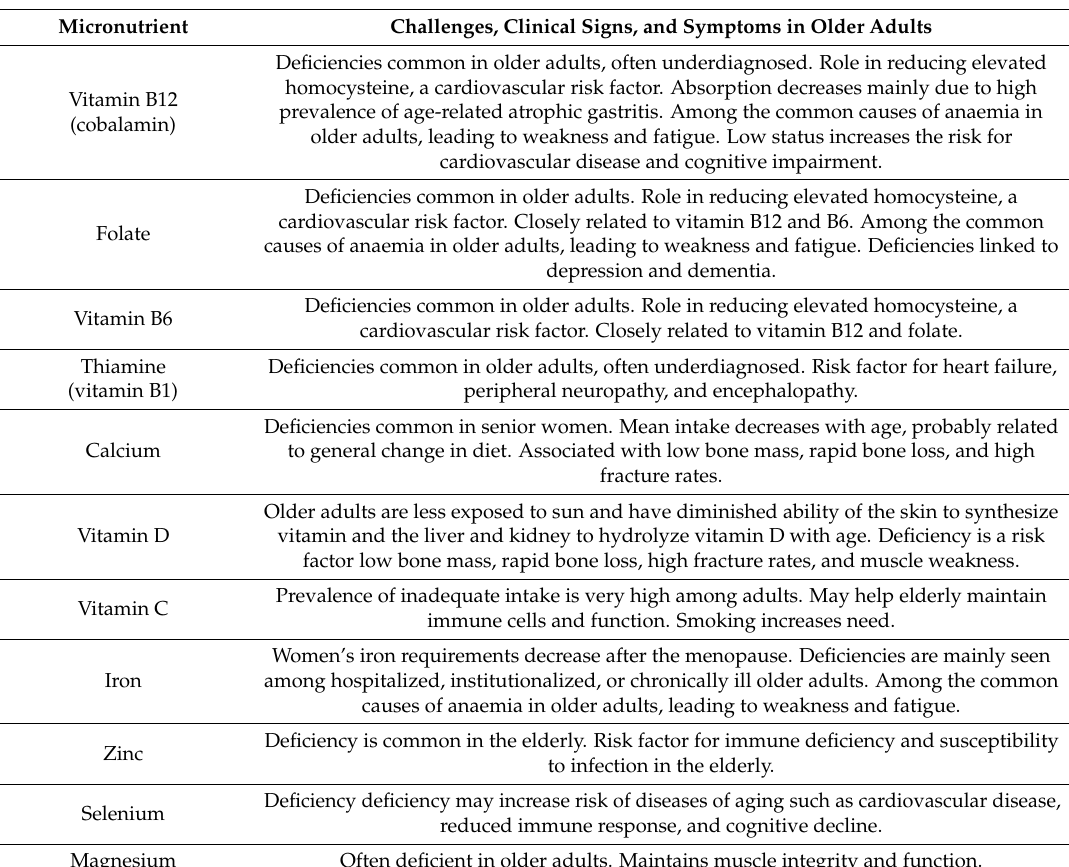
Table 2. Critical nutrients in older adults